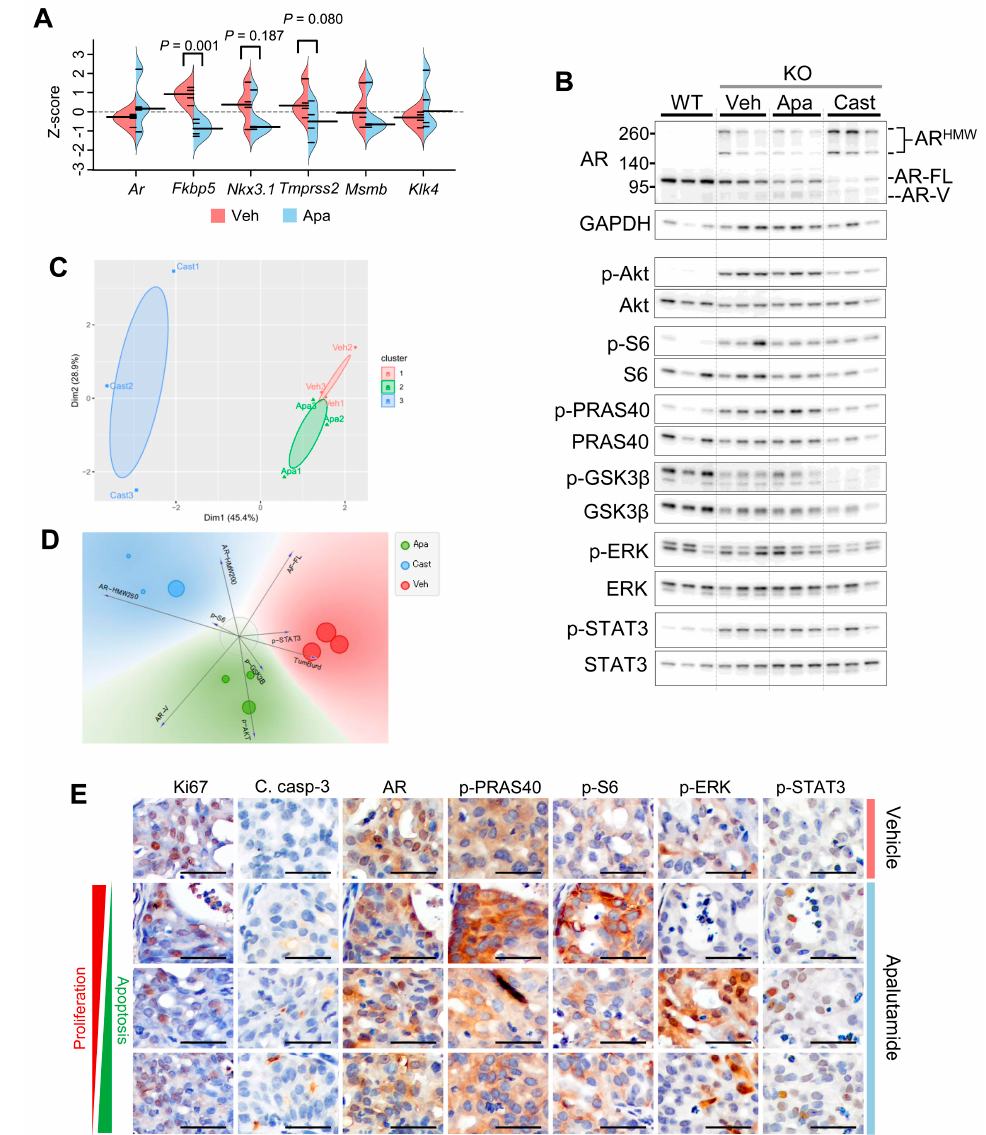
Figure 2. Profiling Pten -deficient castration-naïve prostate cancer (CNPC) response to apalutamide therapy. Prostates from a subset of mice ( n = 4 mice/group) in Figure 1A were utilized to profile the effects of apalutamide therapy on androgen receptor (AR) transcriptional activity. ( A ) Analysis of Ar and AR target genes by qRT-PCR: violin plots show the distribution; long beanlines indicate the mean and short beanlines represent individual samples; p values indicate significance of the Student t -test. The effects on the molecules associated with survival pathways were compared between four weeks of treatment with the vehicle, apalutamide (30 mg/kg, p.o. 5 times/week) and surgical castration in Pten -deficient (CNPC). Samples were collected four hours after the last treatment dose and a normal prostate from wildtype (WT) mice were included for reference. Samples were analyzed by semi quantitative Western blot analysis with ImageJ. ( B ) Western blots of full-length AR (AR-FL), AR splicing variant (AR-V), AR high-molecular weight (AR-HMW) and the signaling molecules associated with PI3K/AKT, MAPK and STAT3 signaling. Semiquantitative densitometric analysis was performed in ImageJ; proteins were first normalized to GAPDH and phosphorylated proteins were normalized to total protein. ( C ) Supervised clustering by partitioning around medoids of semiquantitative Western blot data illustrates distinct delineation between treatment responses in tumor samples. ( D ) Freeviz plot showing visual multivariate correlates to treatment. Length of the vectors indicate strength of association and marker size corresponds to tumor burden. ( E )